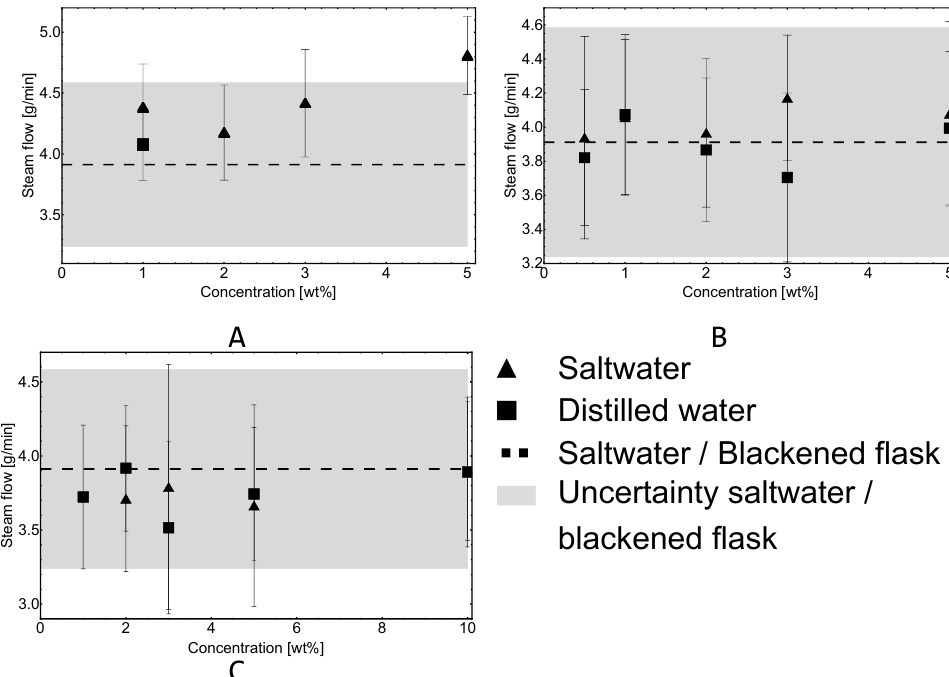
Figure 2. Steam flow as a function of particle mass concentration for carbon nanotubes MWCNT ( A ), iron oxide Fe 3 O 4 nanoparticles ( B ), and NT AQUA DEALTOM composition ( C